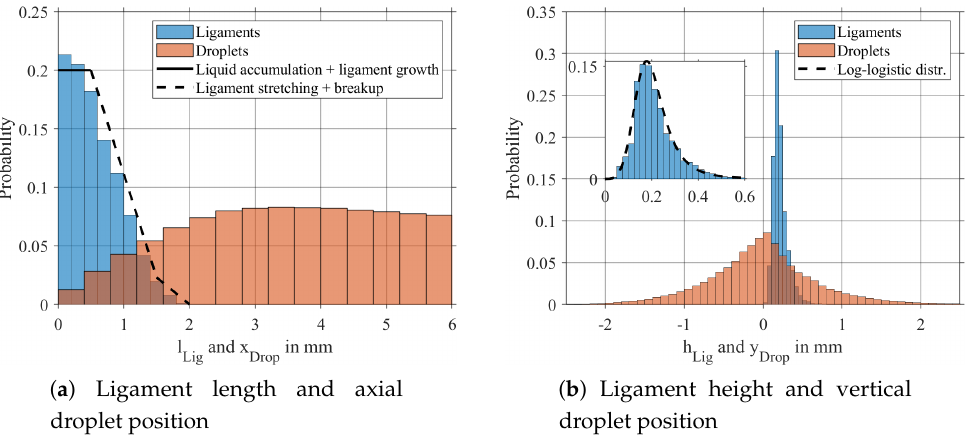
Figure 11. Ligament length scales and droplet positions for p g = 5bar, u g = 70m/s, h a = 230µm.